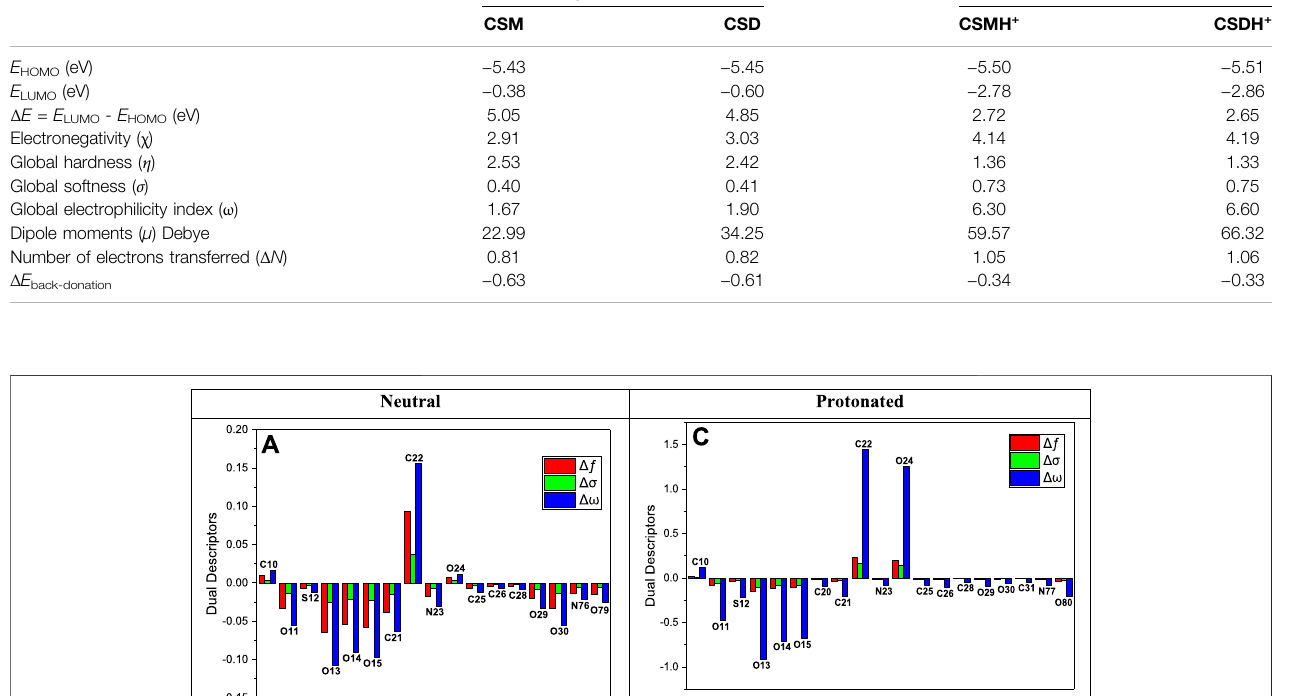
TABLE 3 | DFT parameters of the protonated and neutral CSM and CSD surfactants. Parameter